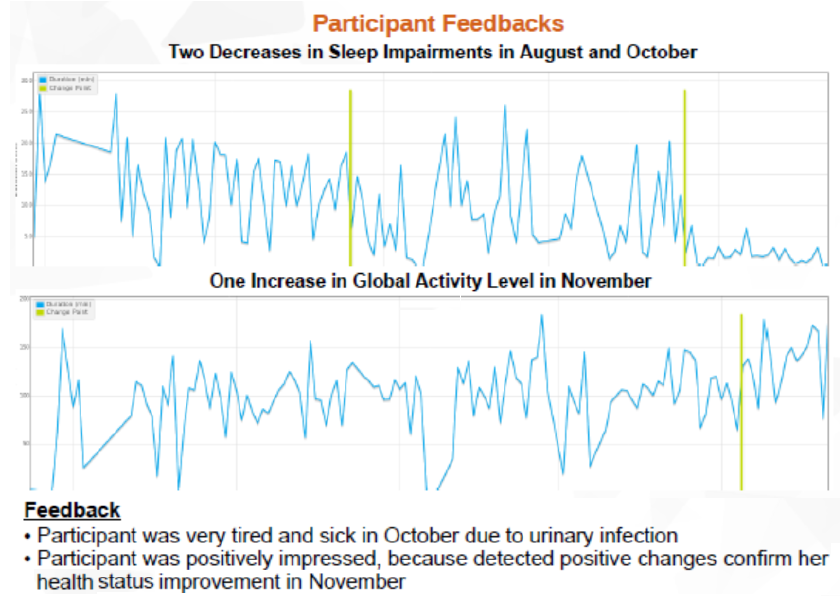
Figure 10. Detected behavior changes by “ChangeTracker” and corresponding participant